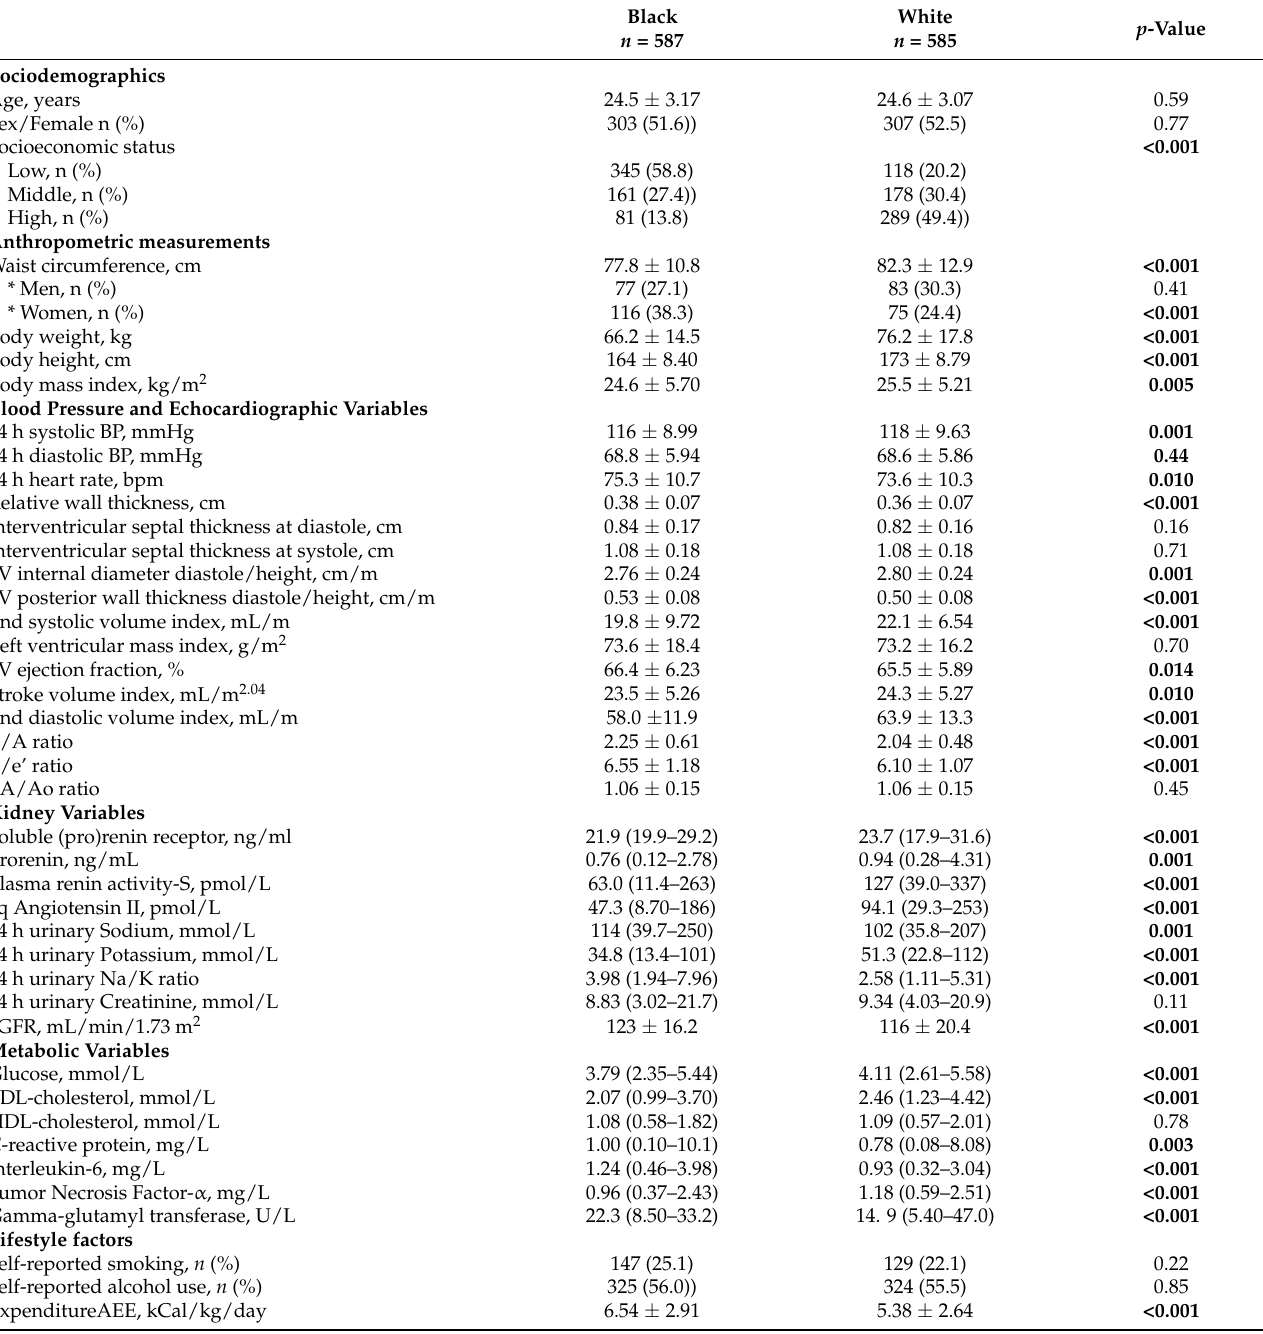
Table 2. Comparisons between black and white